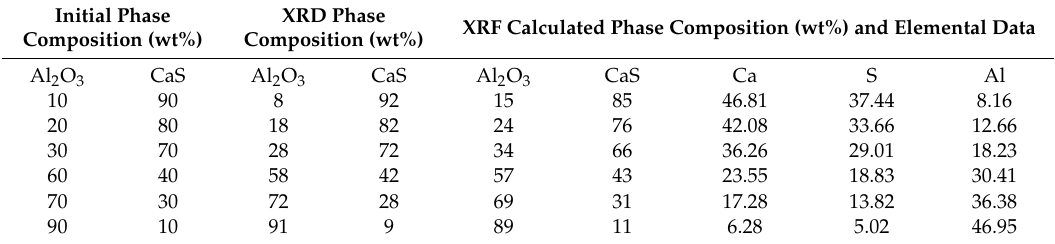
Table 2. Initial sample composition, XRD and XRF analyses for binary aluminum oxide-calcium sulphide phases of Al2O3–CaS.